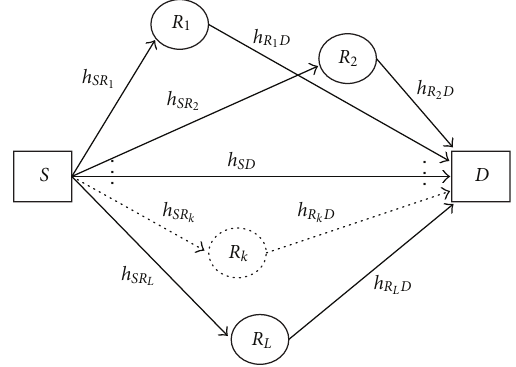
Figure 1: An illustration of a dual-hop cooperative wireless system with L + 2 wireless nodes: a source node S , L relay nodes R k , k = 1,2, ... , L , and a destination node D